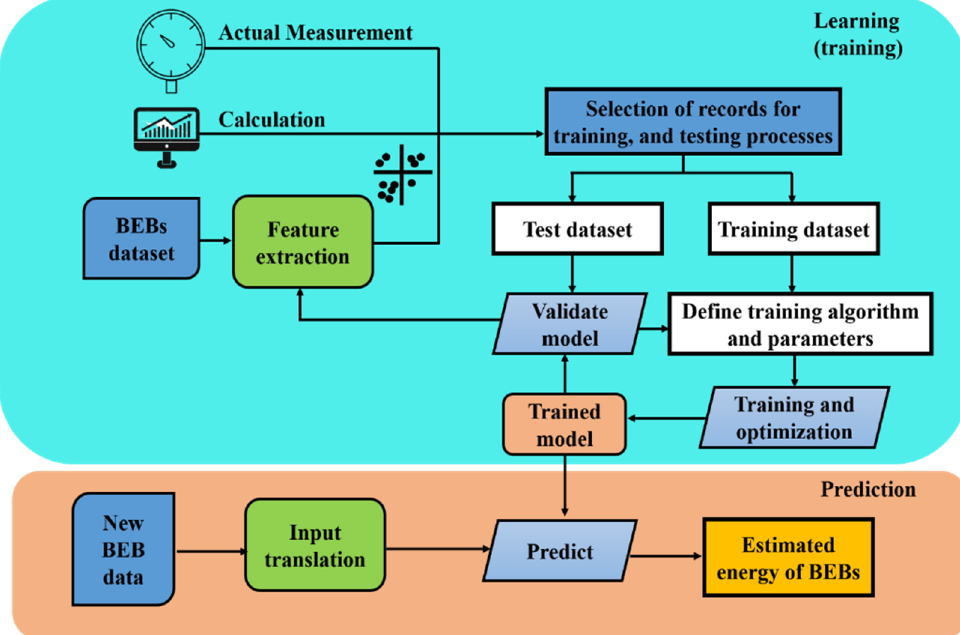
Figure 7. General scheme diagram of a supervised learning algorithm for estimating the energy consumption of BEBs.